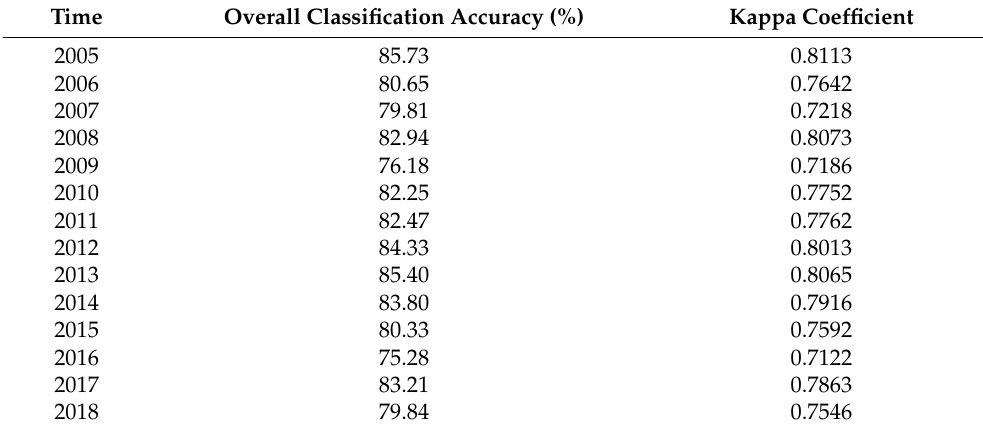
Table 2. Overall classification accuracy and Kappa coefficient of remote sensing